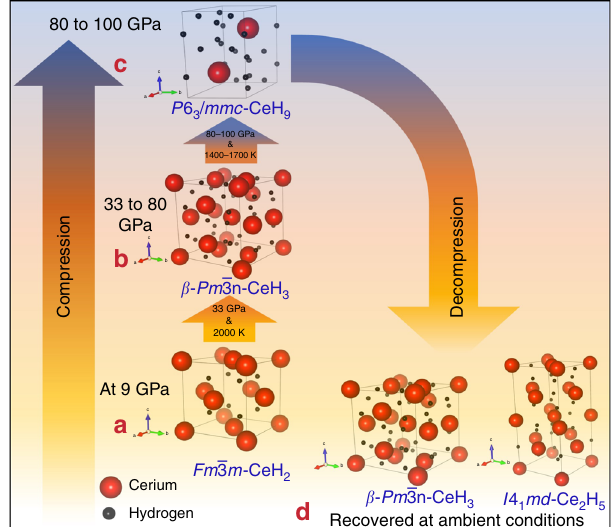
Fig. 3 Pressure temperature path for the synthesis and stability of various Ce – H phases. a Starting at 9 GPa, cerium reacts with hydrogen to form Fm (cid:1) 3 m (cid:2) CeH , which remained stable up to 33 GPa. b At 33 GPa with laser 2 heating, Fm (cid:1) 3 m (cid:2) CeH in H 2 medium reacted to form β (cid:2) Pm (cid:1) 3 n (cid:2) CeH 2 β (cid:2) Pm (cid:1) 3 n (cid:2) CeH remained stable up to 80 GPa. c Laser heating of 3 β (cid:2) Pm (cid:1) 3 n (cid:2) CeH in H 2 medium at 80-100 GPa resulted in the occurrence of 3 the P6 3 /mmc -CeH 9 superhydride. The superhydride phase was found to be stable up to the maximum pressure reached in our studies i.e. 100